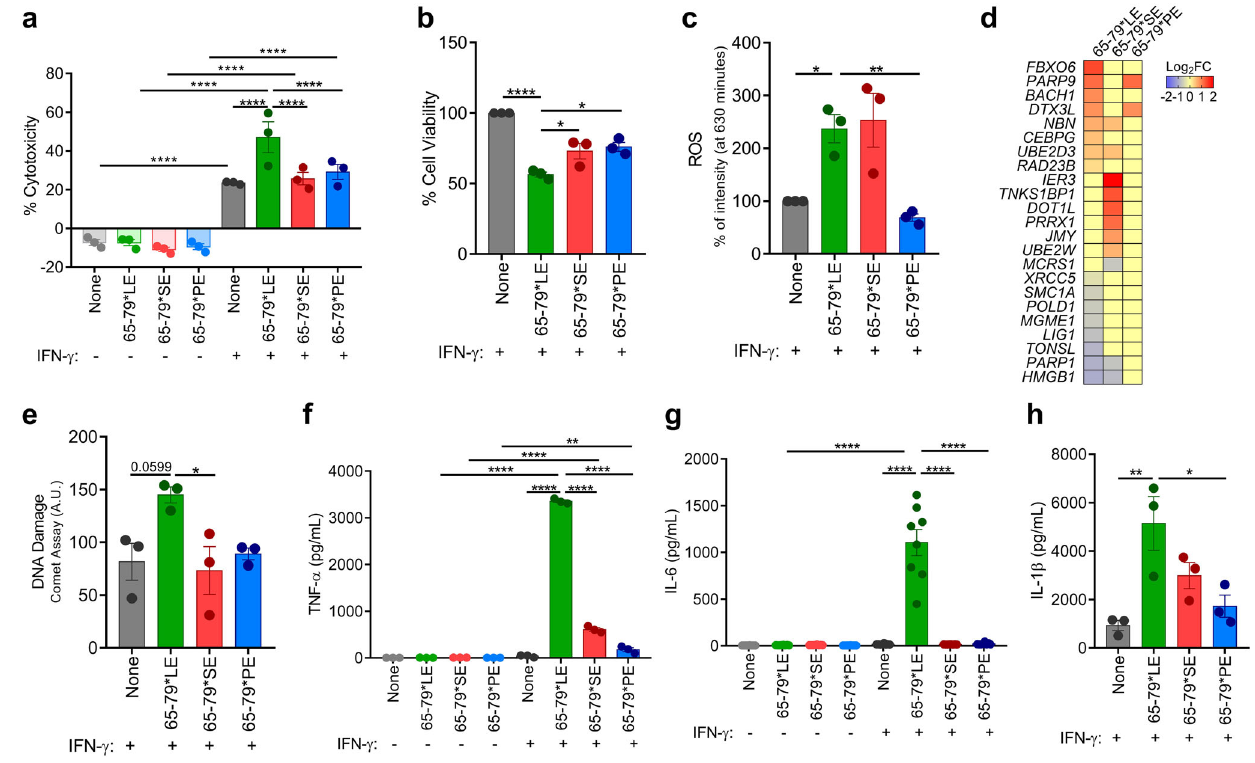
Fig. 4 Allele-speci fi c activation of cell death, pro-in fl ammatory cytokine production and DNA damage by the LE. a – c Cell death a , viability b , and ROS levels c , in THP-1 cells exposed to different allelic epitopes ( n = 3). d Heatmap of DNA damage-related genes (Model B) in THP-1 cells exposed to different allelic epitopes ( n = 4). e DNA damage, quanti fi ed by the comet assay, in THP-1 cells exposed to different allelic epitopes ( n = 3). f – h Supernatant levels of the pro-in fl ammatory cytokines TNF- α f , IL-6 g , and IL-1 β h , in THP-1 macrophages exposed to different allelic epitopes ( n = 3). Data represent mean ± SEM. One-way ( b , c , e , h ), or two-way ( a , f , g ) ANOVA. * p < 0.05, ** p < 0.01, *** p < 0.001, **** p < 0.0001. See also Supplementary Fig.